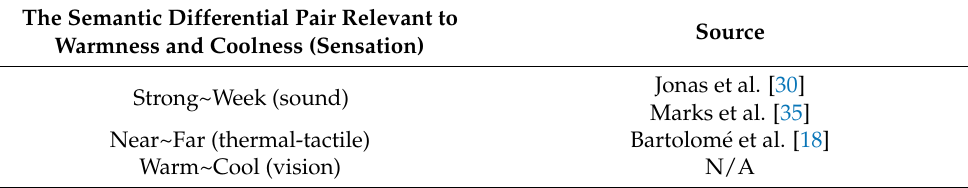
Table 4. Semantic differential association between color warmness/coolness and various sensations.